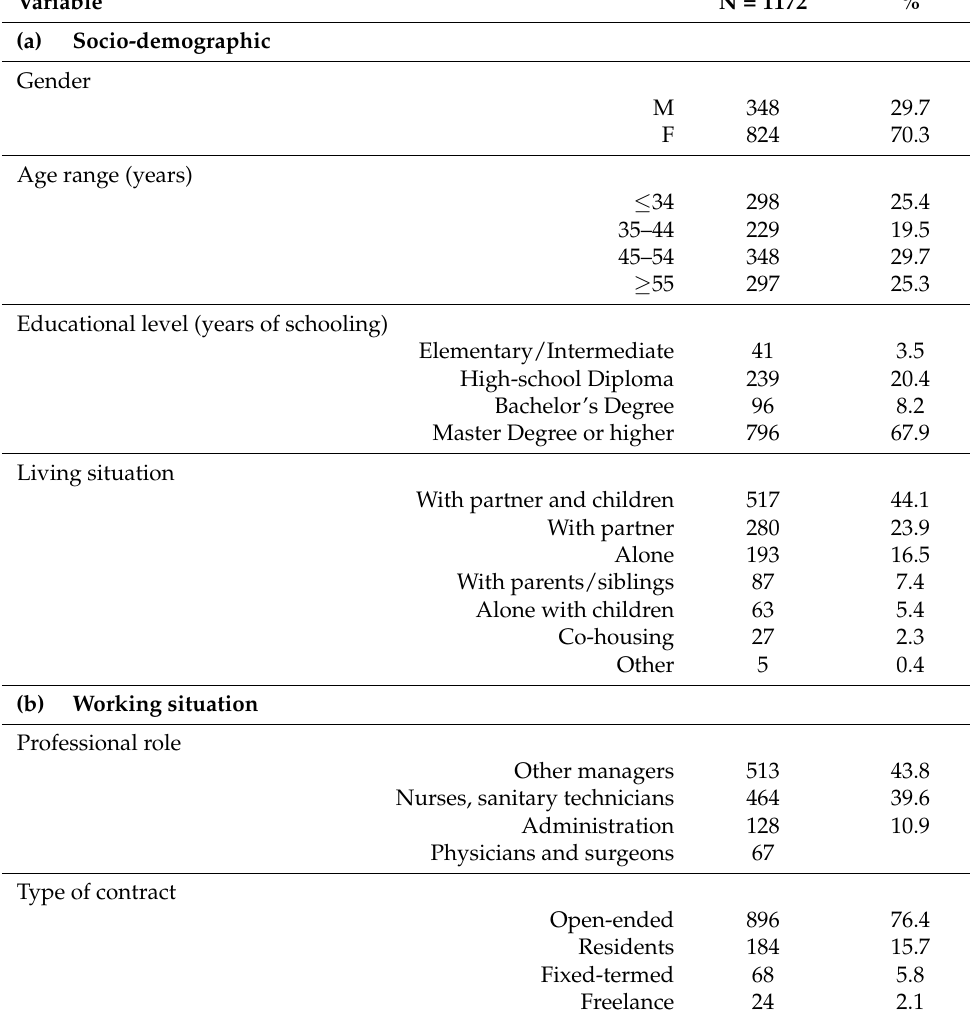
Table 1. General summary of the